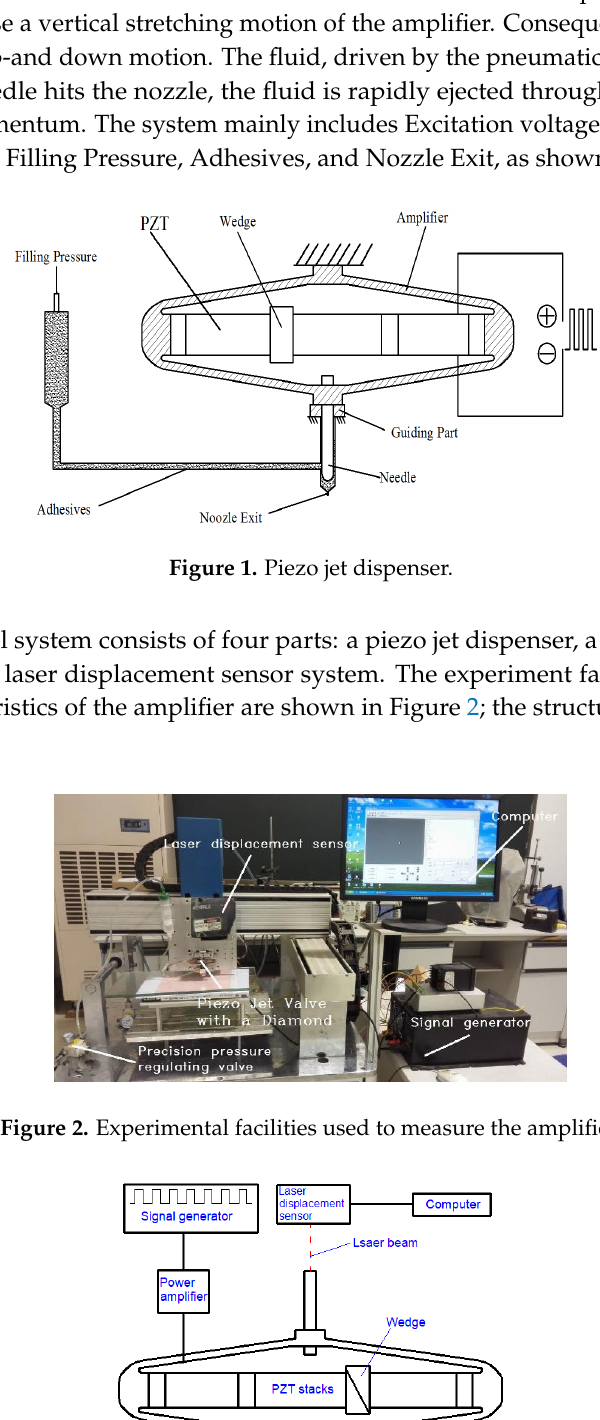
Figure 3. Structure diagram for the amplifier’s experimental facilities.